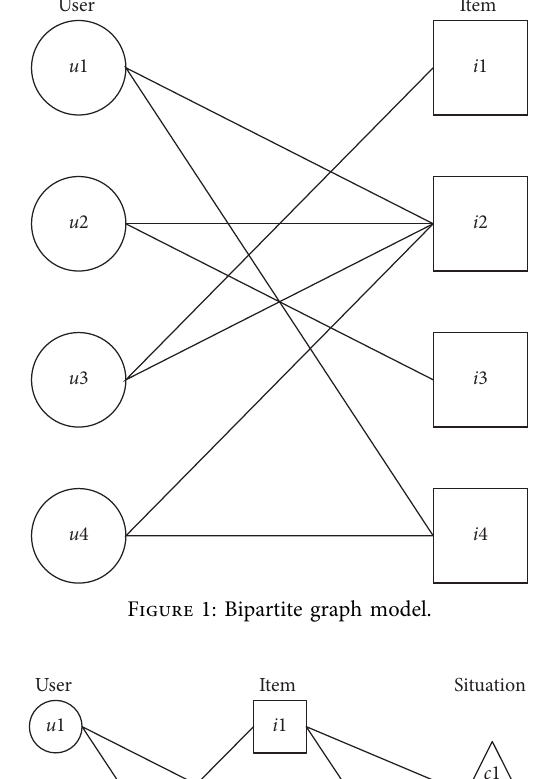
Figure 1: Bipartite graph model.